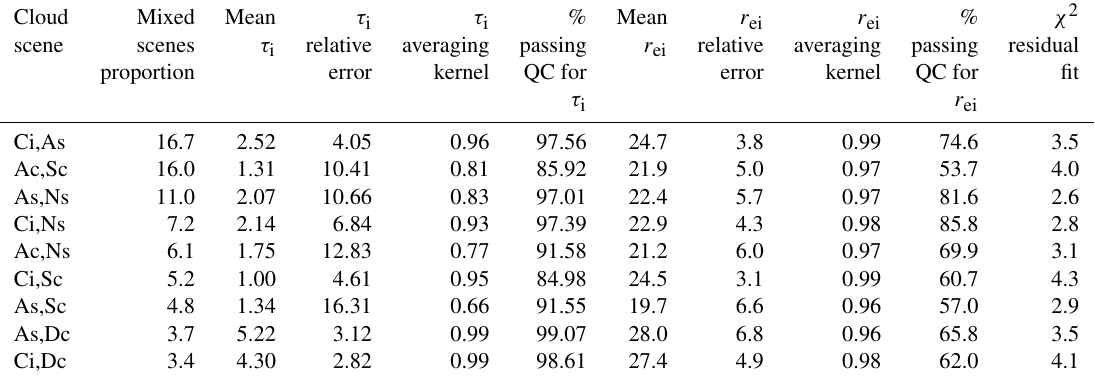
Table 5. Cloud ice properties for cloudy sky with multiple cloud types for the first nine most observed cloud scenes at the AIRS FOV scale. All else the same as Table 4.